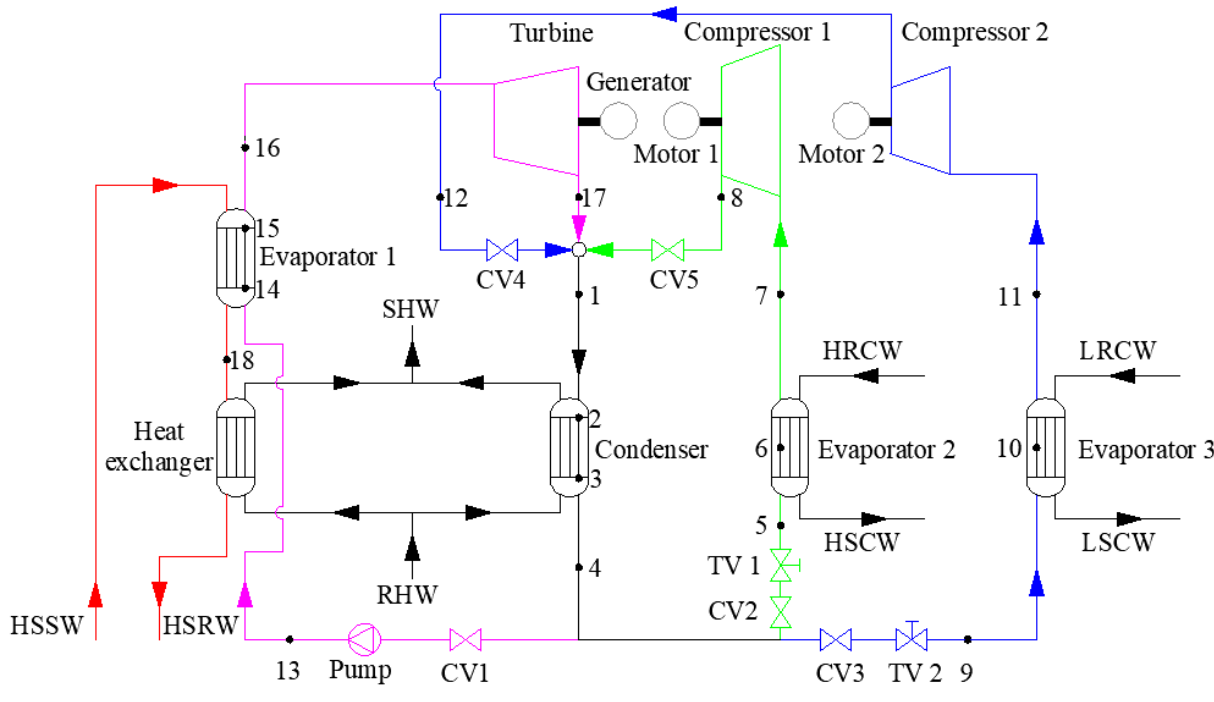
Figure 1. Schematic diagram of the ORC-TSVCC system.